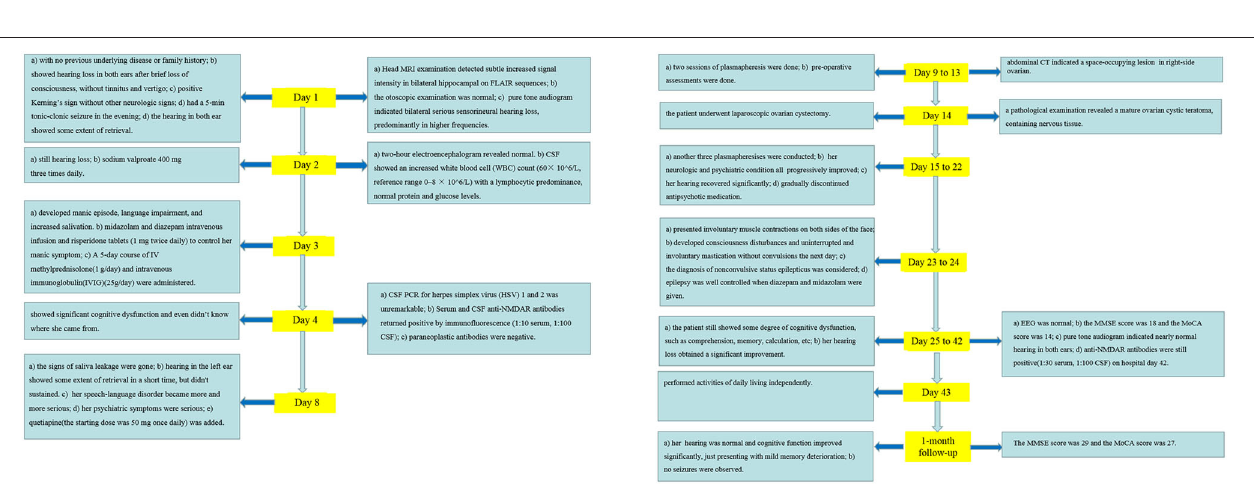
FIGURE 4 | Clinical course of the